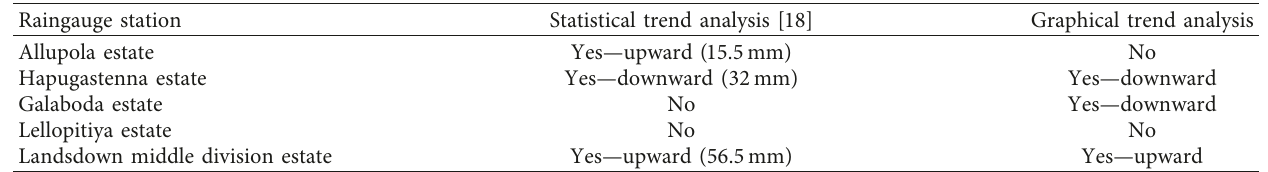
Figure 3: Graphical trends for annual rainfalls for Denawaka Ganga catchment. (a) Allupola estate, (b) Hapugastenna estate, (c) Galaboda estate, (d) Lellopitiya estate, and (e) Landsdown middle division estate. Table 5: Comparison results for annual rainfalls for Denawaka Ganga catchment.